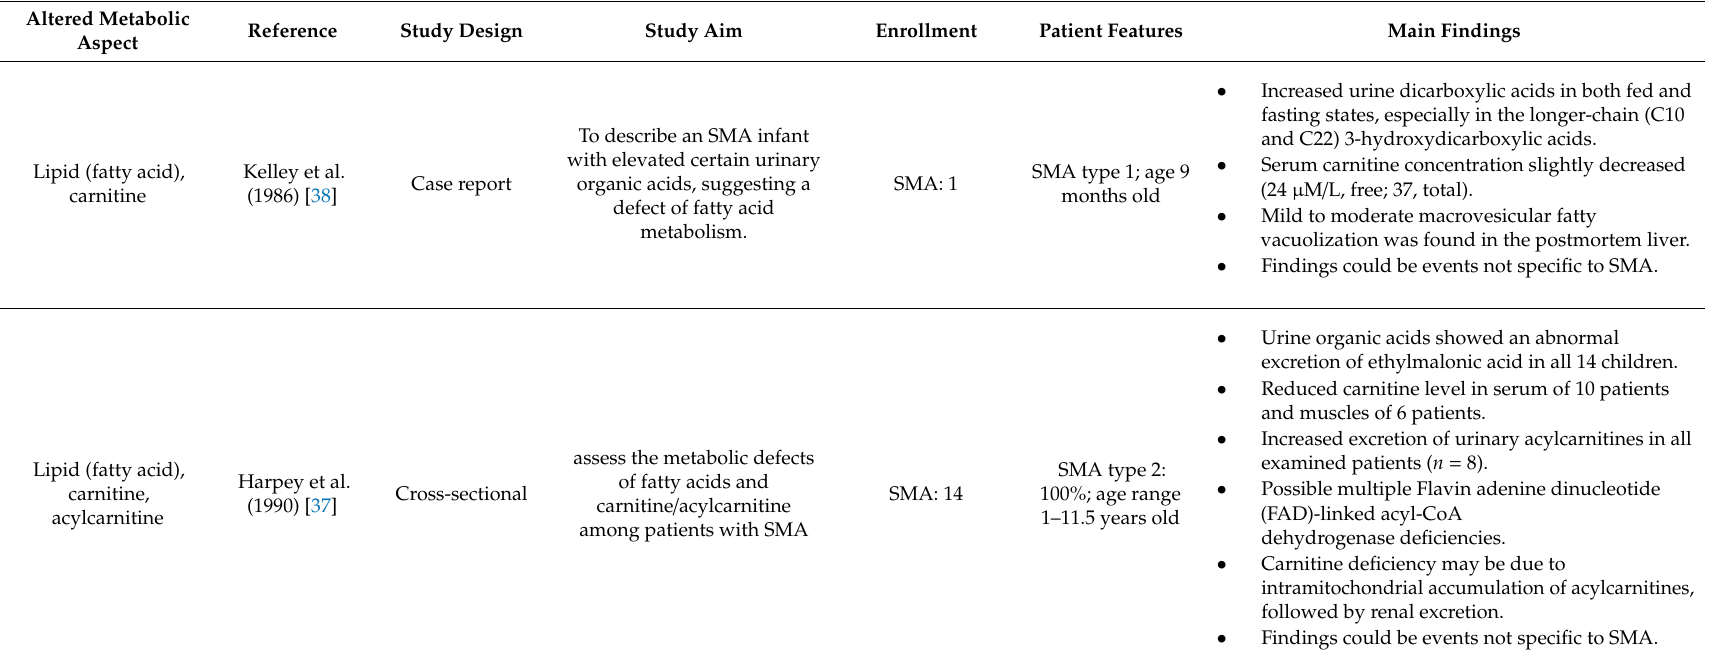
Table 1. Altered Lipid Metabolism in Patients with Spinal Muscular